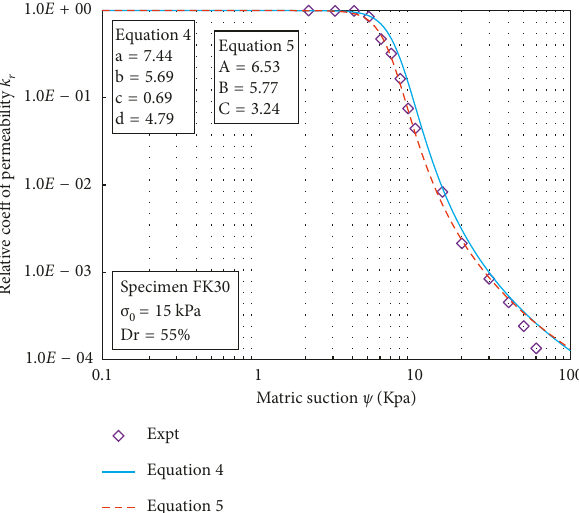
Figure 6: Permeability coefficient changes against matric suction for soil FK10.